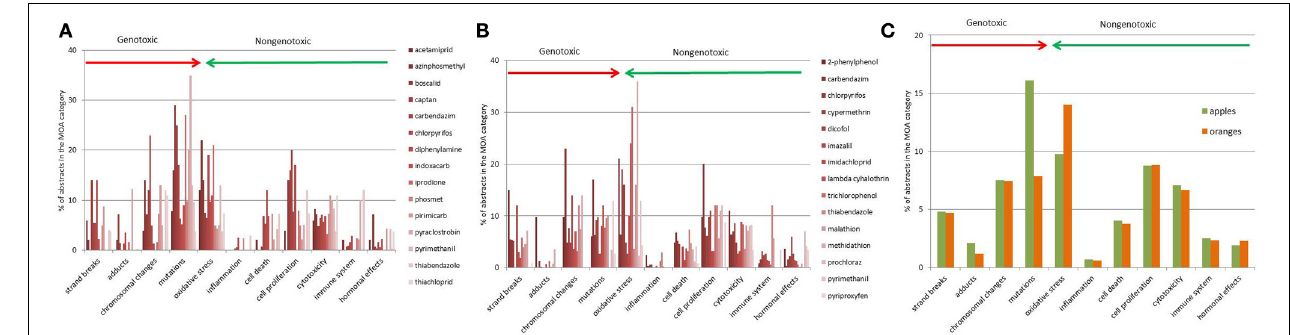
FIGURE 2 | Literature distribution of the 15 individual pesticides most commonly detected in apple samples, data is shown for 11 selected sub-categories (A). The literature distribution over the MOA taxonomy for individual pesticides most commonly detected in oranges, data is shown for